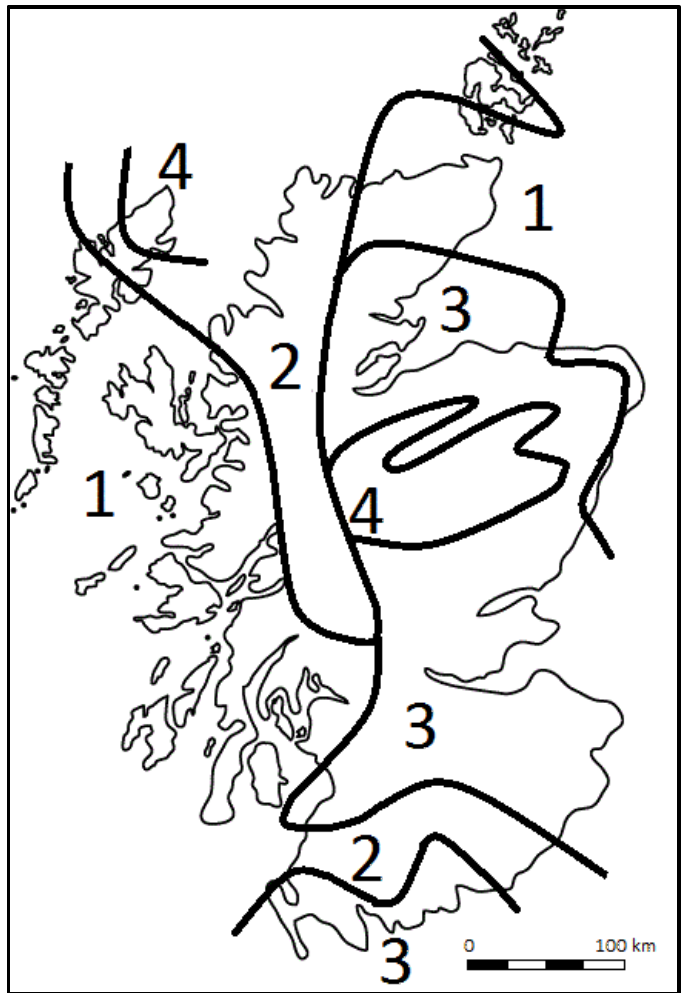
Figure 1. Sketch map of zones showing current and predicted suitability zones for Sitka spruce in Scotland by 2080. (1) remains largely suitable; (2) partially suitable becoming more suitable; (3) partially suitable becoming largely unsuitable; (4) remains largely unsuitable. Based on a simplified version of data presented in Ray